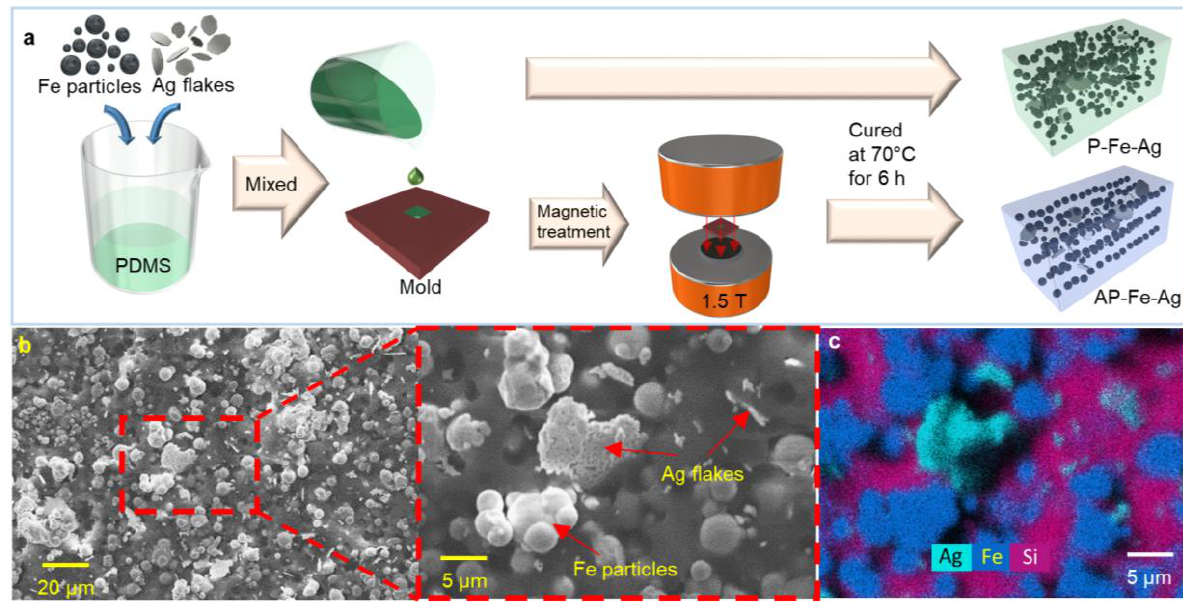
Figure 1. ( a ) Schematic of the preparation method of P-Fe-Ag y and AP-Fe-Ag y . ( b ) Scanning electron microscopy (SEM) images of P-Fe-Ag 5 and the zoom-in image to show the shape of Ag flake, ( c ) and its energy dispersive X-ray spectroscopy (EDS) analysis of the cross-section.